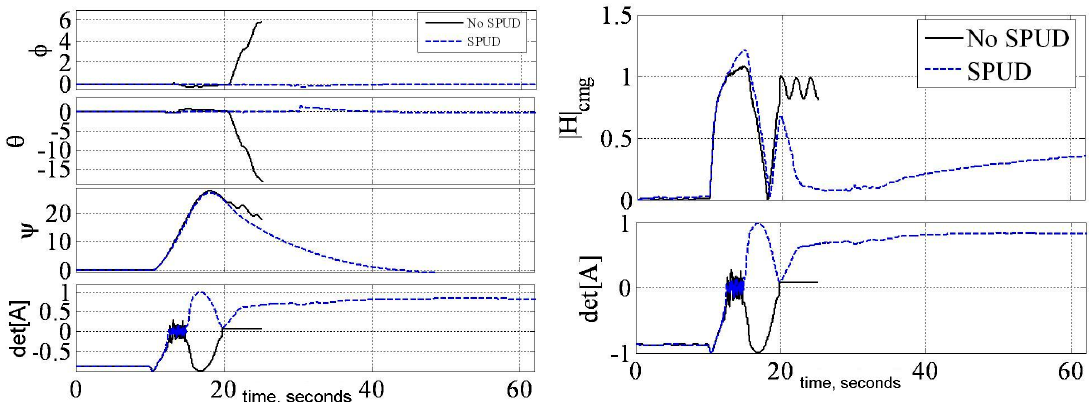
Figure 11. EXPERIMENTATION: direct comparison with SPUD versus without SPUD.